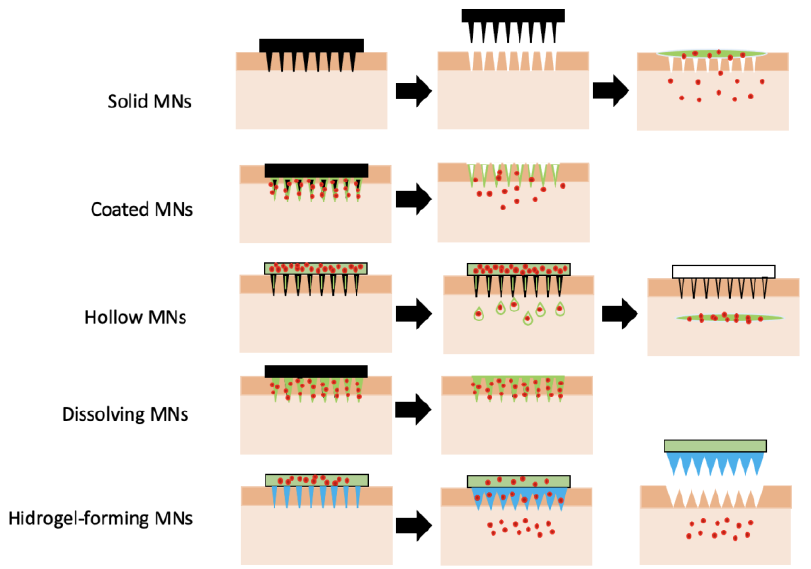
Figure 5. Schematic diagram showing the different types of microneedles and the mechanisms through which the different microneedles are used for drug delivery (adapted from [85]).